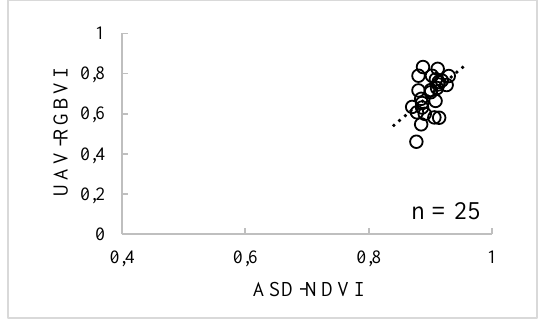
Figure 7. Regression of the UAV-based RGBVI and ASD Fieldspec3-based NDVI per plot for the third sampling date (18.05.2014, ASD &